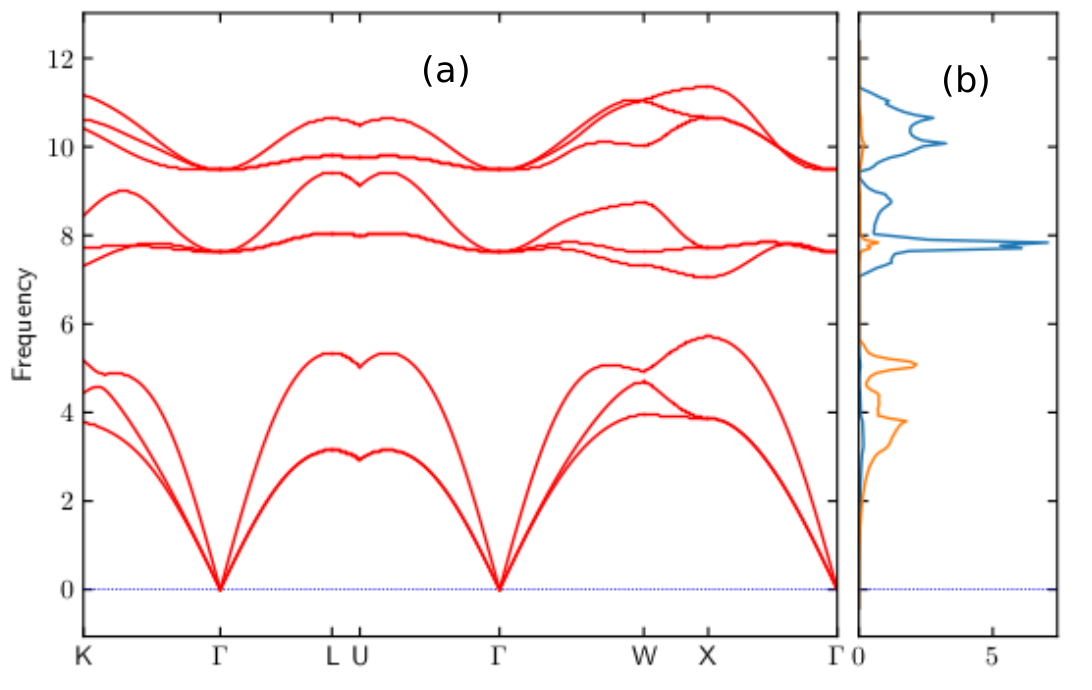
Figure 3. Calculated phonon dispersion curve in (THz) ( a ) and Phonon DOS ( b ) of VIrSi alloy.